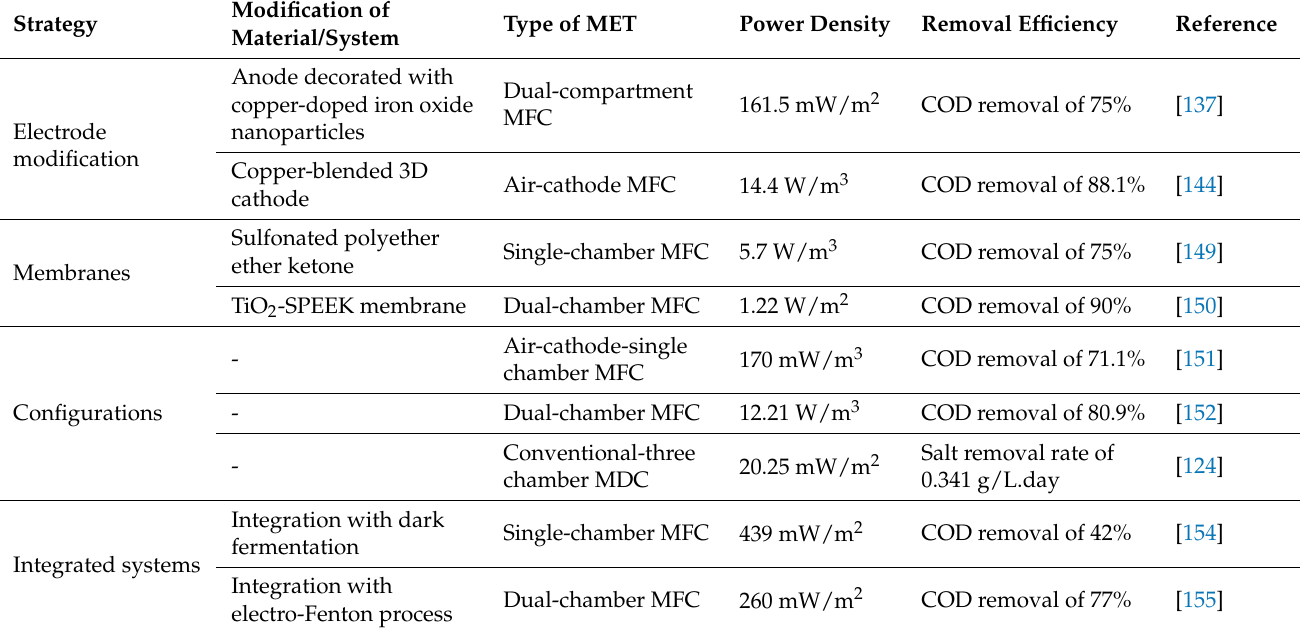
Table 5. Strategies for improving the performance of